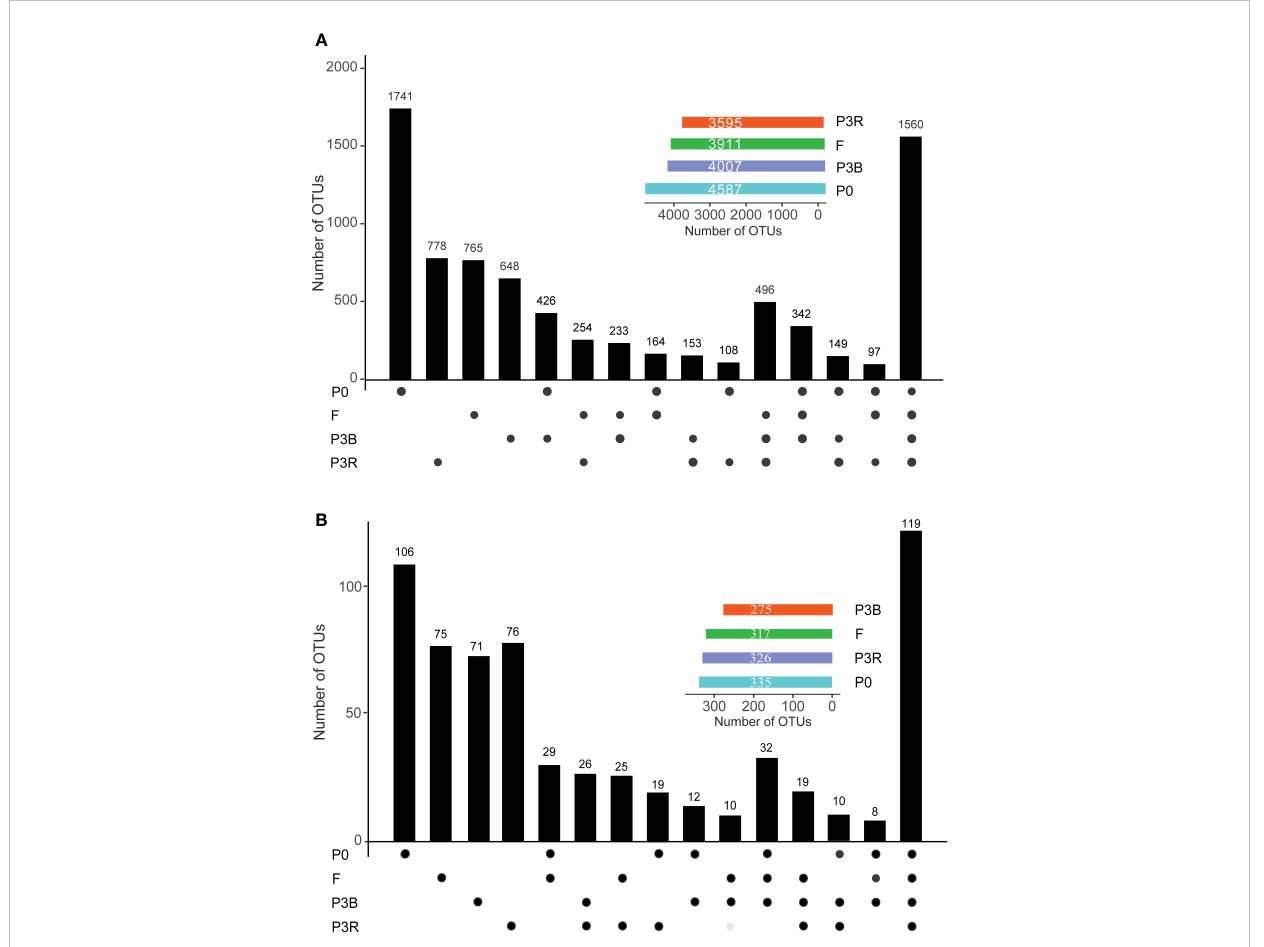
FIGURE 4 Number of unique and shared OTUs in each treatment group. (A) Bacteria; (B) Fungi. Insets show total number of OTUs in each group. OTUs, operational taxonomic units. P0, control soil; F, one-year fallow soil; P3R, Rhizosphere soil after three years consecutive monoculture; P3B, Bulk soil after three years consecutive